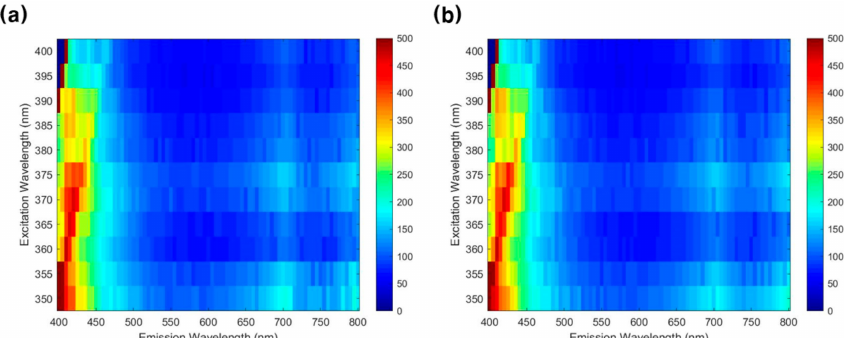
Figure 4. Fluorescence emission results from 400 to 800 nm bands for the excitation light from 350 to 400 nm bands: ( a ) E. coli and ( b ) S. typhimurium .